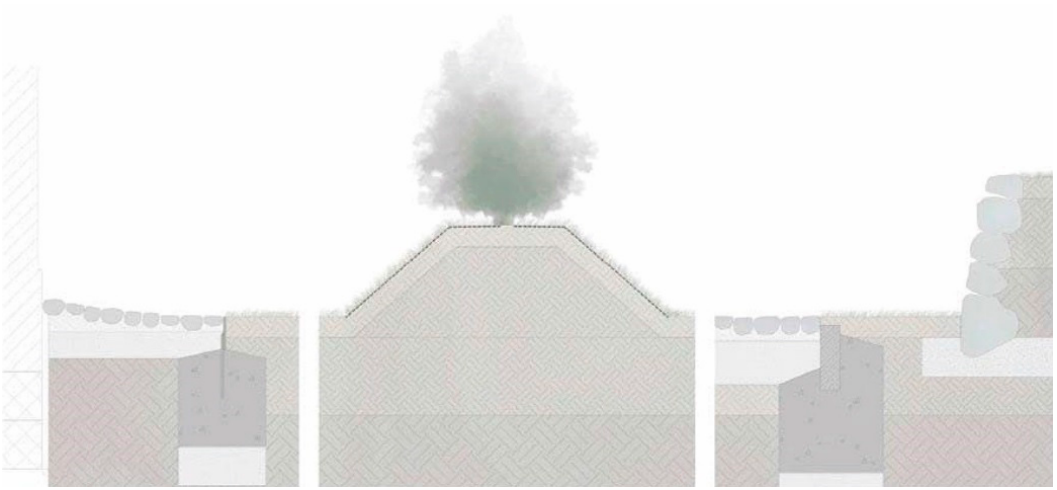
Figure 10. Suggested borders and thresholds in the village.